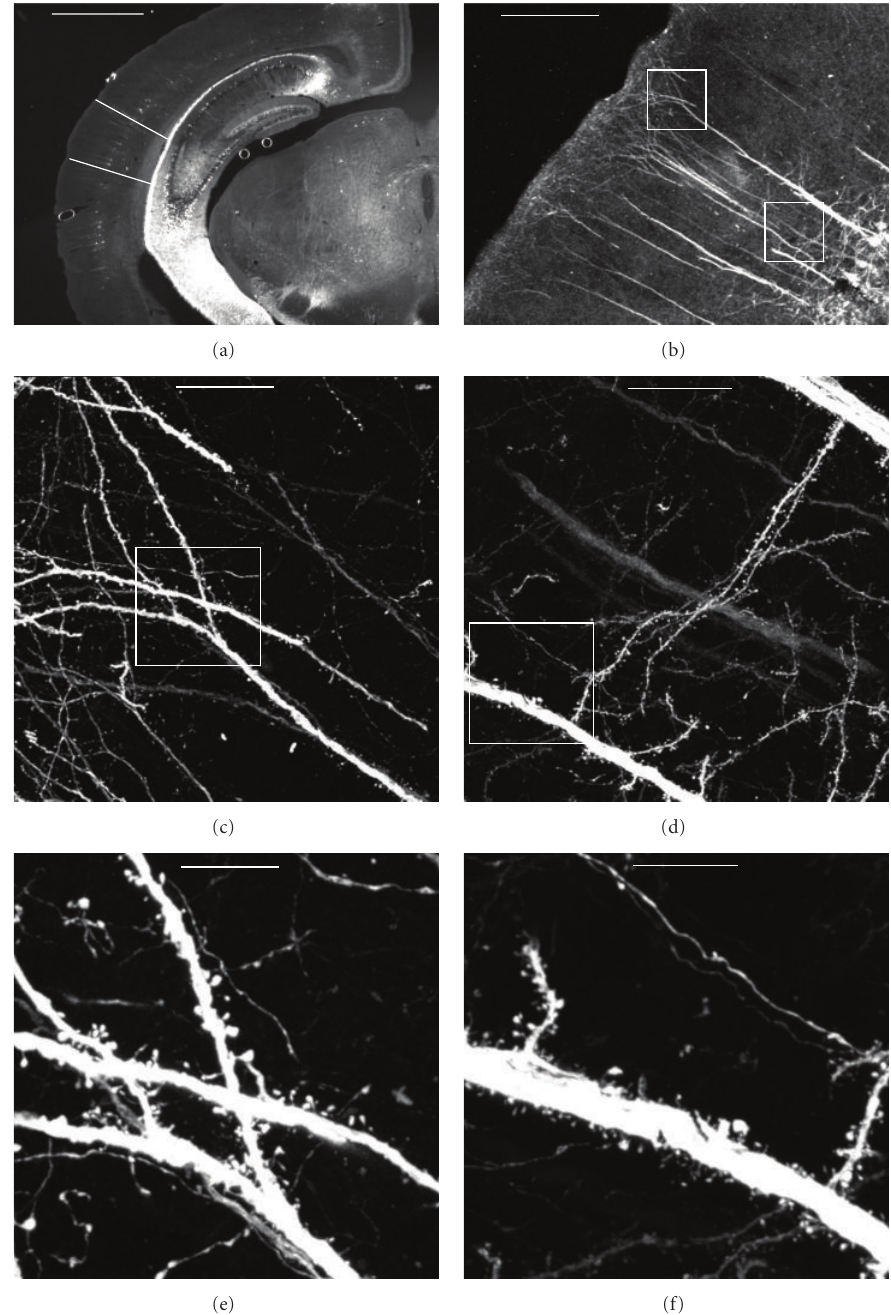
Figure 2: Imaging dendritic structures within primary auditory cortex. (a) Low magnification epifluorescence image of a coronal brain section from a prestin KO mouse. The same section is shown in all panels. A1 was localized at the light microscopic level using a brain atlas. Scale bar: 1mm. (b) Maximum intensity projection through the thickness of a 10x confocal image stack from A1. Boxes indicate the laminar locations imaged. Scale bar: 200 μ m. Maximum intensity projection of a 100x, zoom level 0.7 confocal image stack in layer 2/3 (c) and layer 4 (d). Scale bars: 30 μ m. Maximum intensity projection of a 100x, zoom level 2 confocal image stack in layer 2/3 (e) and layer 4 (f). Morphological analysis was carried out on images of this magnification. Scale bars: 10 μ